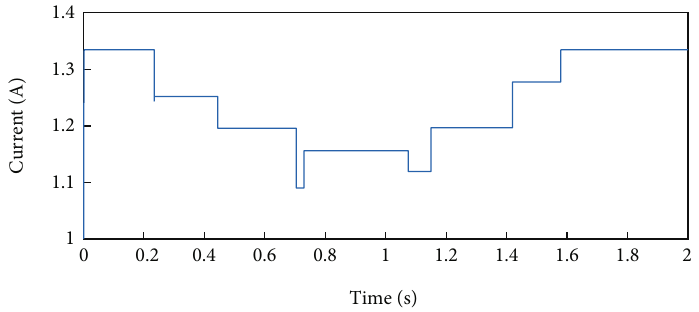
Figure 16: Response of the PVE to fast-changing irradiance (current).